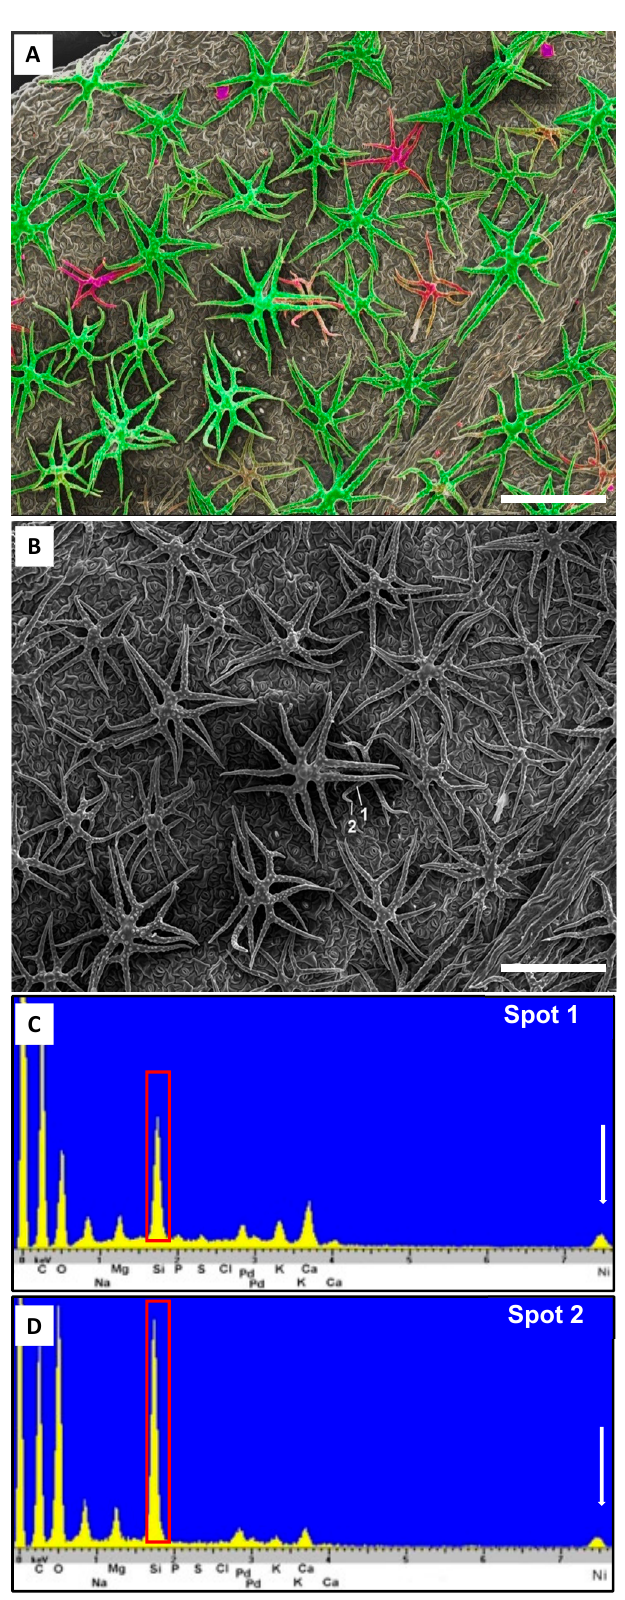
Figure 6. Odontarrhena chalcidica with Si and Ni present ( Cecchi & Selvi , FI-050419, FI). ( A ). Secondary electron image is combined with element mapping of Ca (green) and Si (red) to illustrate mineralization pattern. ( B ). Secondary electron image with analyzed spots associated with energy-dispersive X-ray spectroscopy spectra in ( C ) (shaft) and ( D ) (tip), with Si (denoted by red box) and Ni (denoted by white arrow) presence shown. Scale bars: 200 μ m.